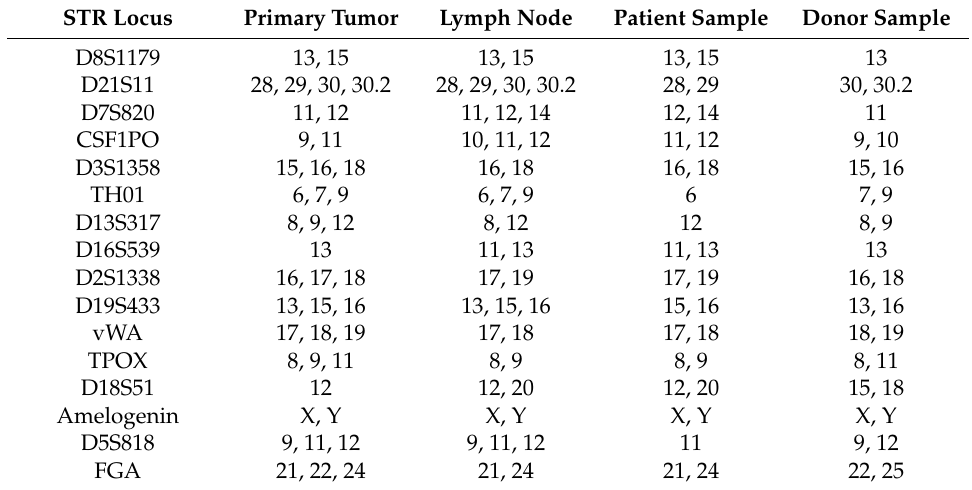
Table 1. STR genotyping of DNA from donor (D), patient (P), primary tumor, and lymph node metastasis. STR units: number of tandem repeats of the locus-specific tetranucleotide sequence [6]. STR Locus Primary Tumor Lymph Node Patient Sample Donor